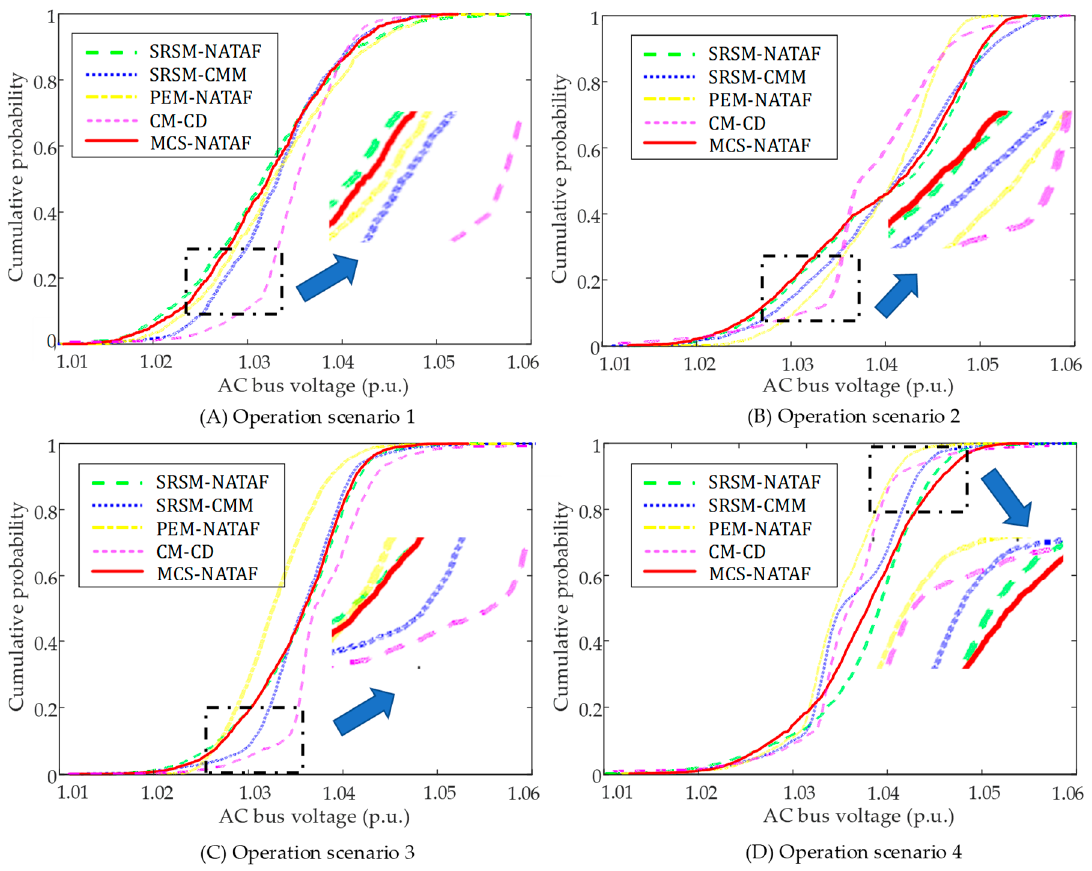
Figure 4. The cumulative probability curves of the voltage magnitude at bus 28 in the four different operation scenarios.